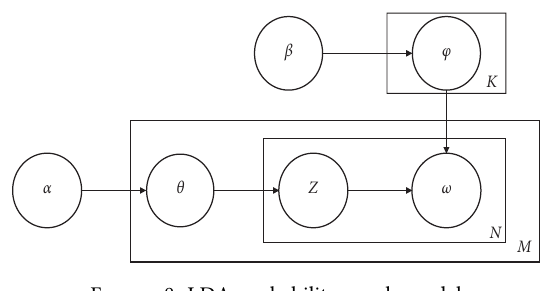
Figure 8: LDA probability graph